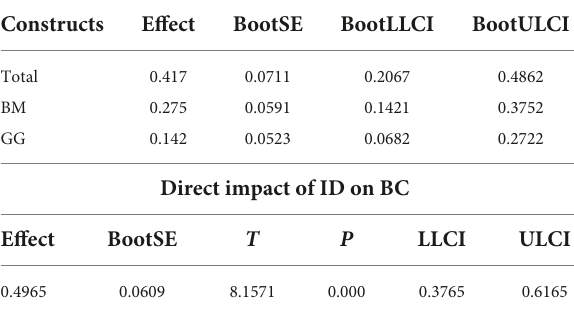
TABLE 8 Mediating role of BM/GG between ID and